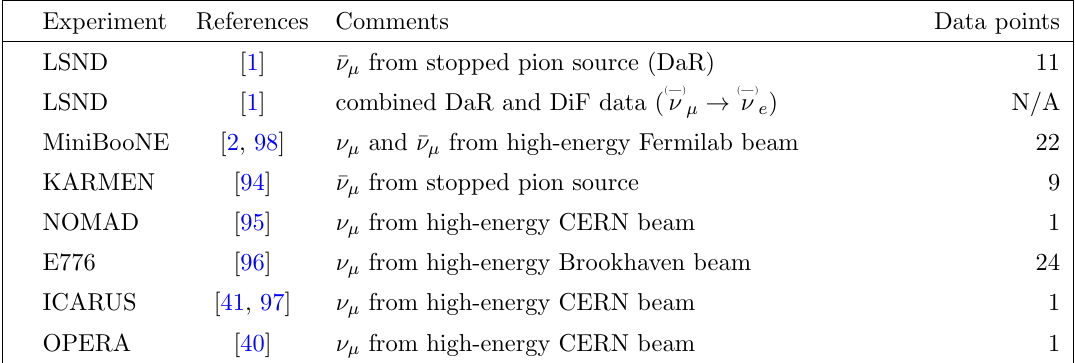
{ ) { ) (cid:23) (cid:22) ! ( (cid:23) e analysis. For LSND, we have carried